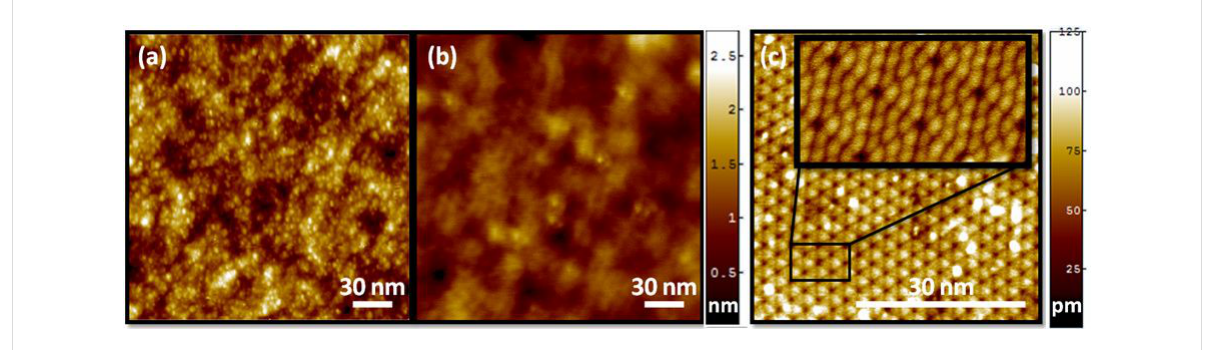
Figure 1: AFM resolution examples: (a) high resolution UHV NC-AFM image of SiO 2 displaying features with radius of curvature ~2.3 nm ( R tip nomi- nally 2 nm, ∆ f = − 20 Hz, A = 5.0 nm, image size = 200 nm × 200 nm) (b) under-resolved UHV NC-AFM image of SiO 2 with the same height scale as (a) ( R tip nominally 30 nm, ∆ f = − 150 Hz, A = 1.0 nm, image size 200 nm × 200 nm) (c) UHV NC-AFM image of Si(111) with inset showing atomic reso- lution (